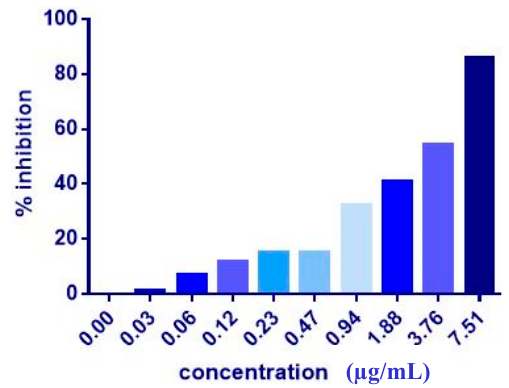
Figure 3. Of cell inhibition (MTT assay) of MCF-7 cells treated with ZER-TP5-iRGD for 72 h.